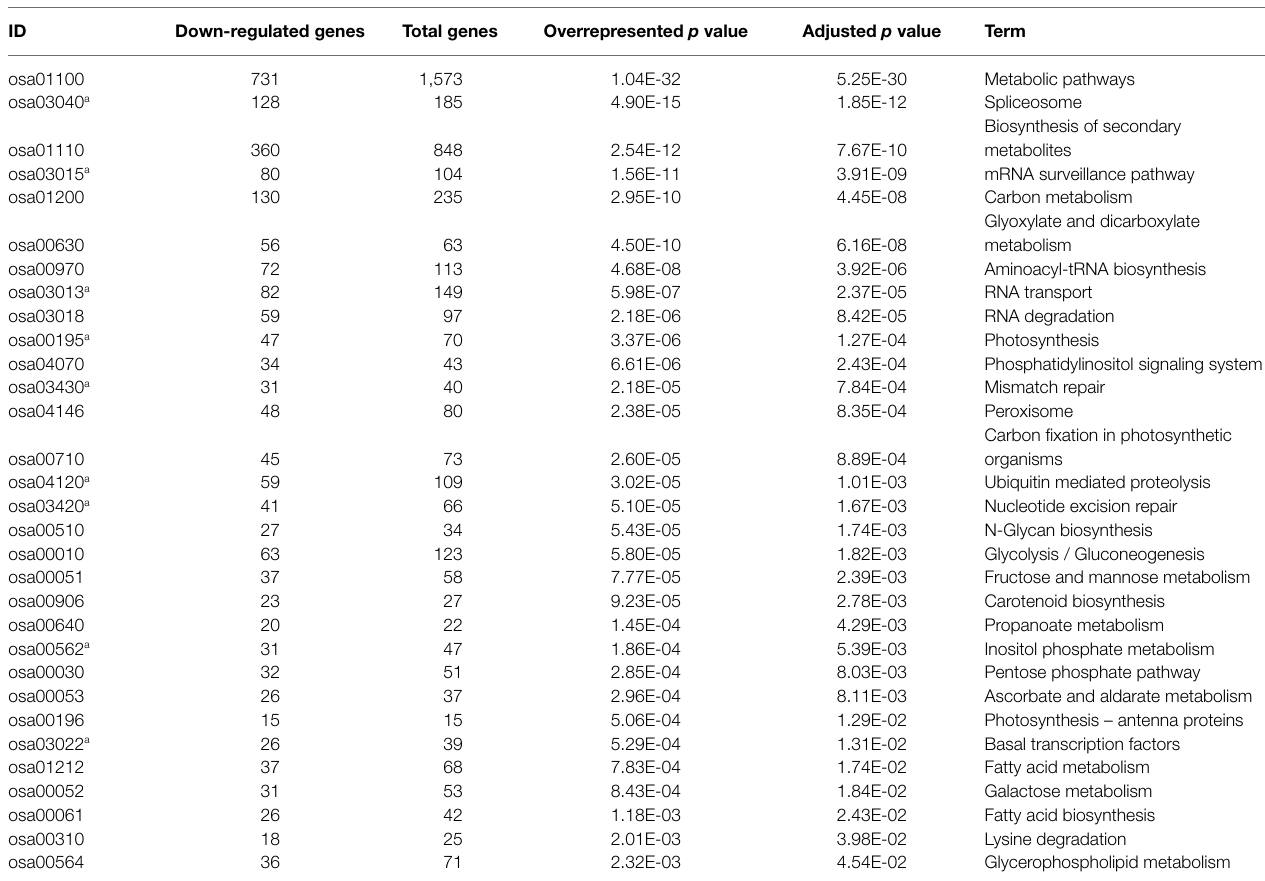
TABLE 2 | KEGG enrichment